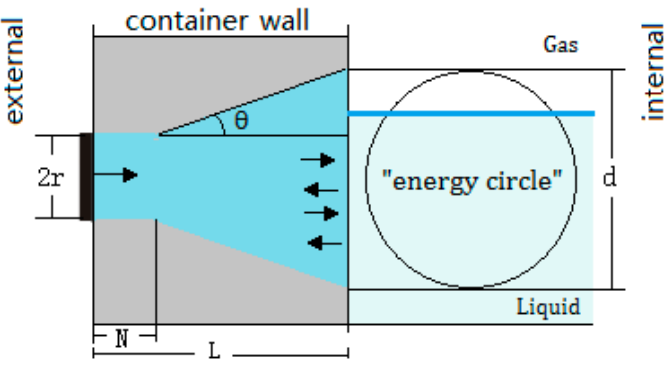
Figure 1. The principle of the proposed liquid level detection based on ultrasonic impedance and echo energy.